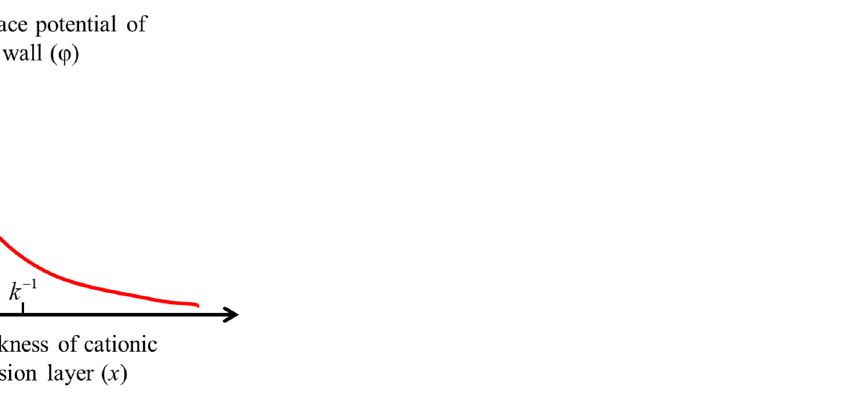
Figure 1. Schematic diagram of the diffusion layer structure on the clay surface.